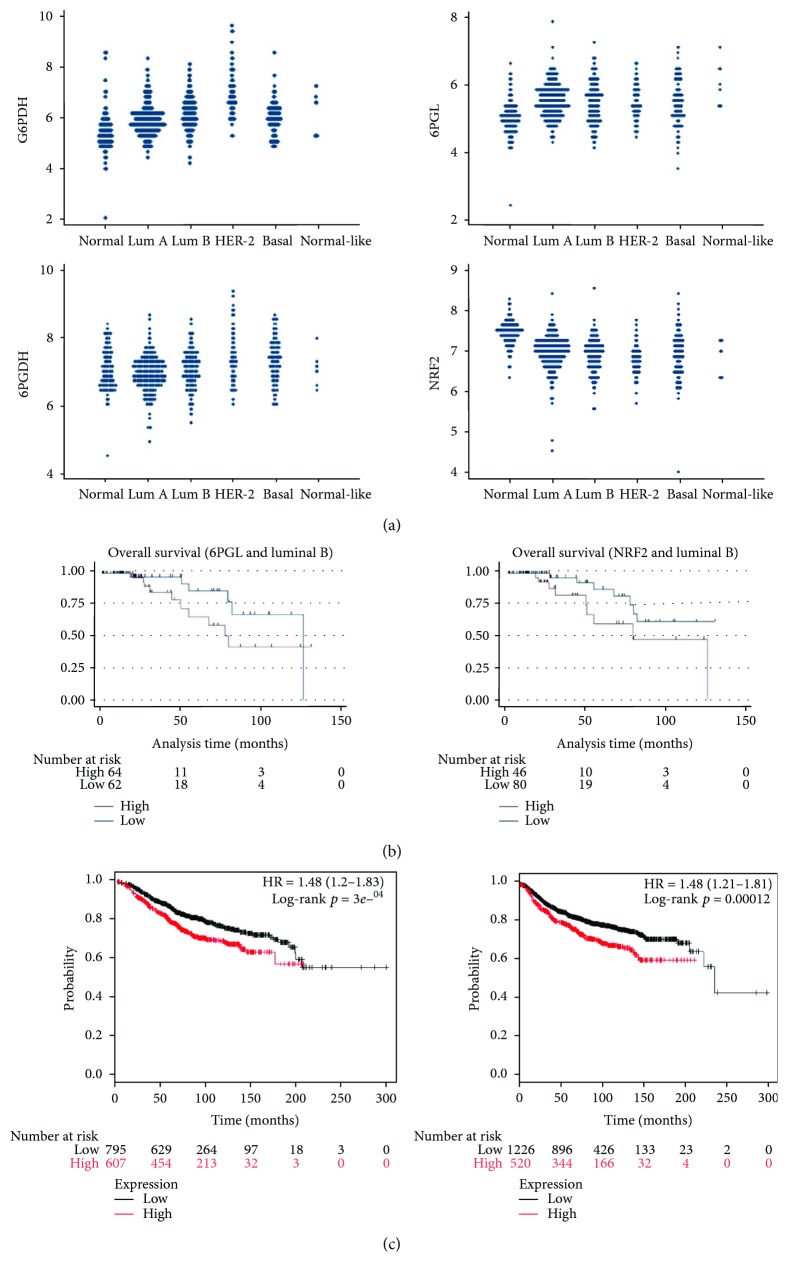
Validation of expression of pentose phosphate pathway-related proteins in a TCGA cohort and Kaplan-Meier plotter. (a). Expression of pentose phosphate pathway-related proteins in a TCGA cohort of breast cancer shows increased expression of G6PDH and 6PGDH. (b). There was a tendency toward longer overall survival with lower expression of 6PGL and NRF2 in the luminal B subtype (p = 0.109 and p = 0.065) (c). Higher expression of G6PDH is associated with longer overall survival (left) and disease metastasis-free survival (right) in a Kaplan-Meier plotter cohort.